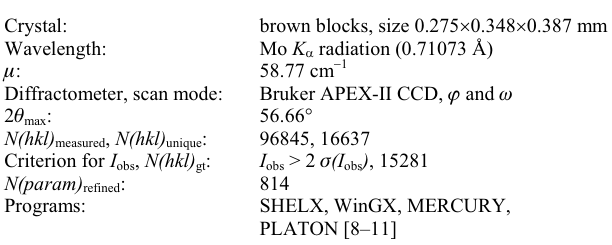
Table 1. Data collection and